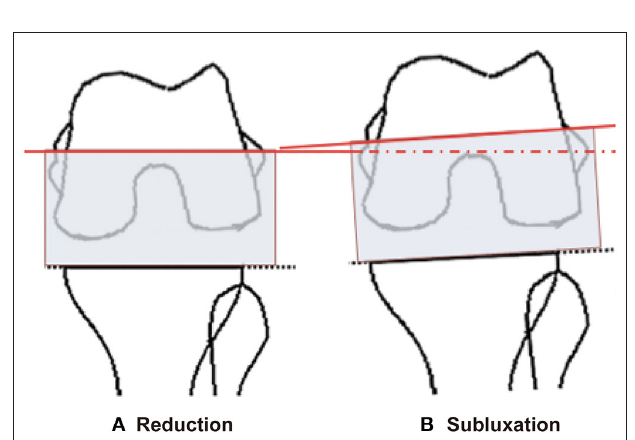
FIGURE 4 | The tibial plateau was taken as the reference for the femoral posterior condylar cut using the gap-balance technique (A) . After subluxating the patellar (B) , varus angle of joint gap was smaller, so the inscribed line created by using the matching rectangular block parallel to the tibial plateau adds an internal rotation. This eventually caused the femoral prothesis to be placed internally rotated.